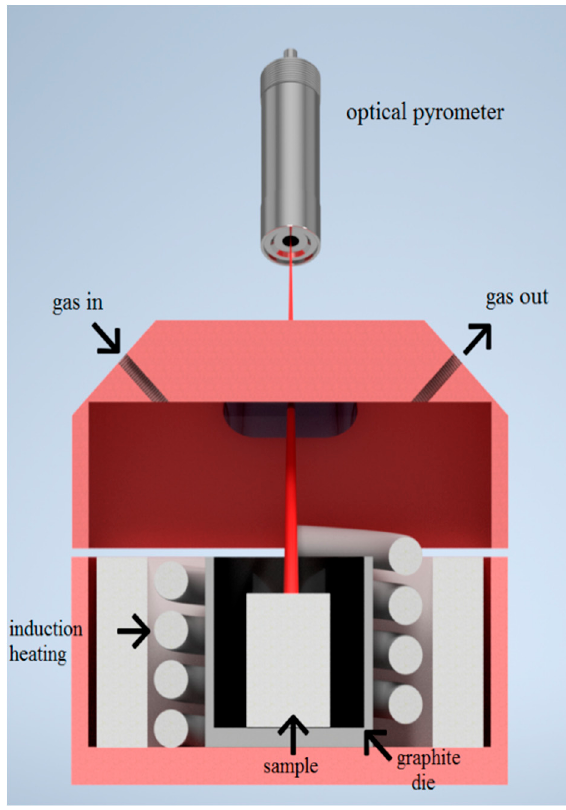
Figure 10. A schematic illustration of the experimental set-up of induction heating.